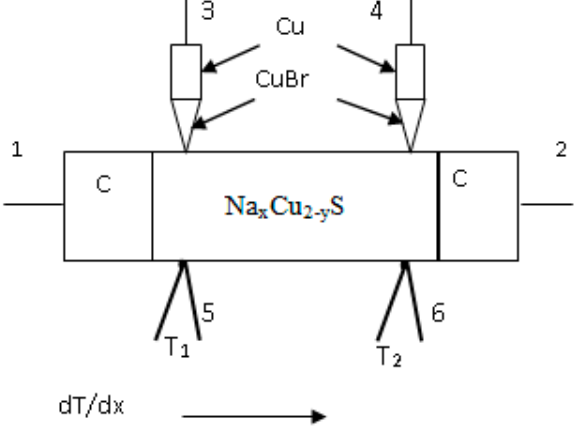
Figure 4. Schematic diagram of a cell for measuring the coefficients of electronic and ionic thermo-emf and electronic conductivity. In the picture, symbols C and c denote Cu probes and electrodes, CuBr is ionic conductor, Na x Cu 2-y S is sample (example), T- thermocouple. The control of the constancy of the chemical composition and the equilibrium state of the samples during measurements was carried out by the EMF of the electrochemical cell Cu / CuBr / sample / Pt, measured between pairs of contacts 3-5 and 4-6, in two cross sections of the sample. Reliable clamping of potential probes 6 and thermocouples 4 to the sample was ensured using flexible wire 5, tightened by springs.